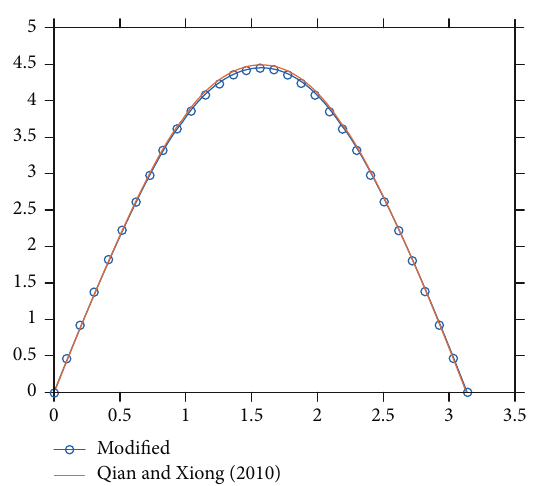
Figure 17: The variations of the system of equations (46) and the solution of the regularized system of equations (12) – (15) for p = 1 , k = 0 : 001 , α = 0 : 01 , and y = 0 : 5 .